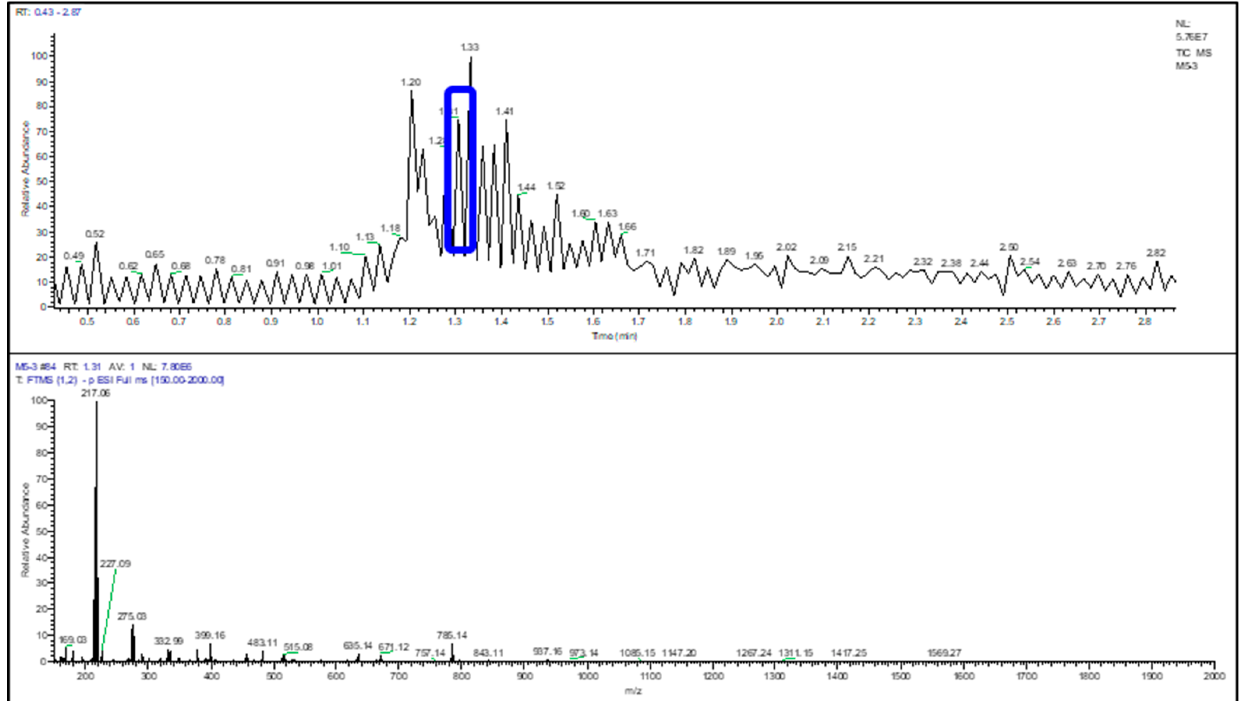
Figure 8. Total ion chromatogram of the S. lanceolata extract of an ion peak at m / z 217.0630 [M + H] + matched the molecular formula C 9 H 15 O 4 P, putatively identi fi ed as (3-Methyloxiranyl)phosphonic acid; (2RS,3SR)-form, Di-2-propenyl ester. E6: 1.0 × 10 6 ; E7: 1.0 × 10 7 .